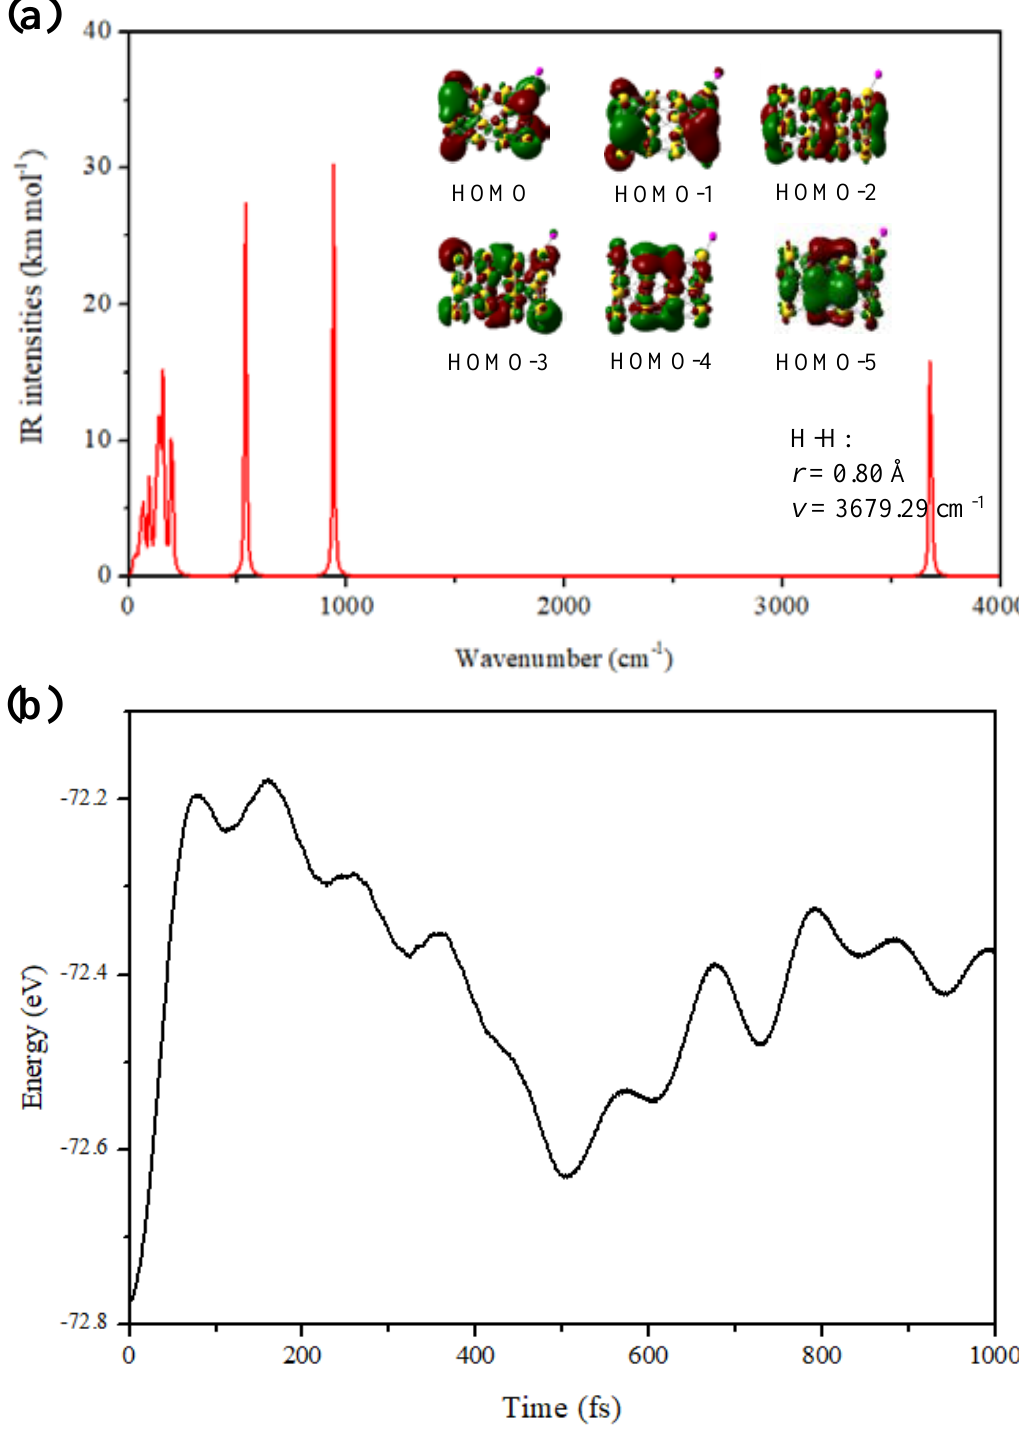
Figure 4. ( a ) Infrared spectrum and molecular orbitals, ( b ) the energy fluctuation with the time step at 300 K of iso1 structure of the Au 26 -H 2 .